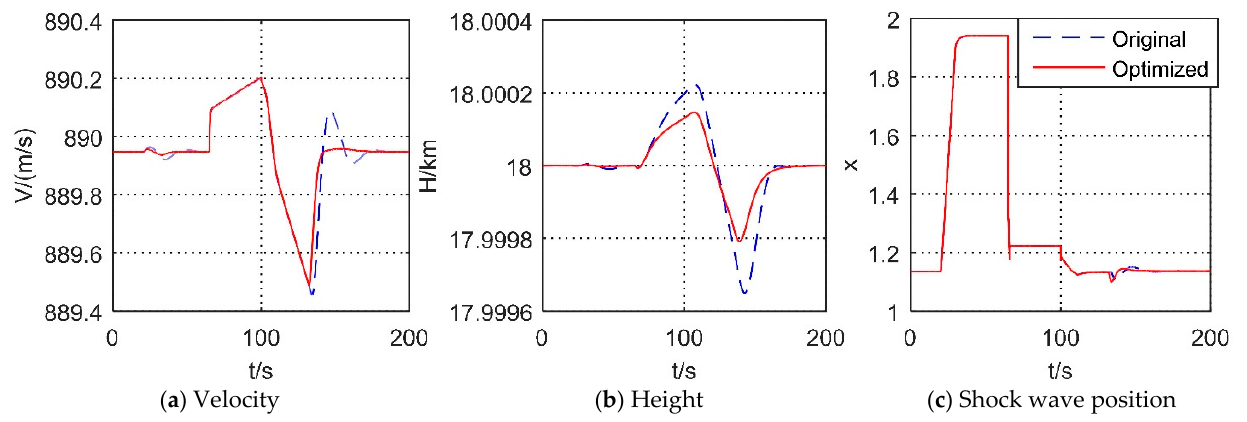
and altitude of the aircraft to change rapidly. At this time, the normal shock wave moves before and after the whole